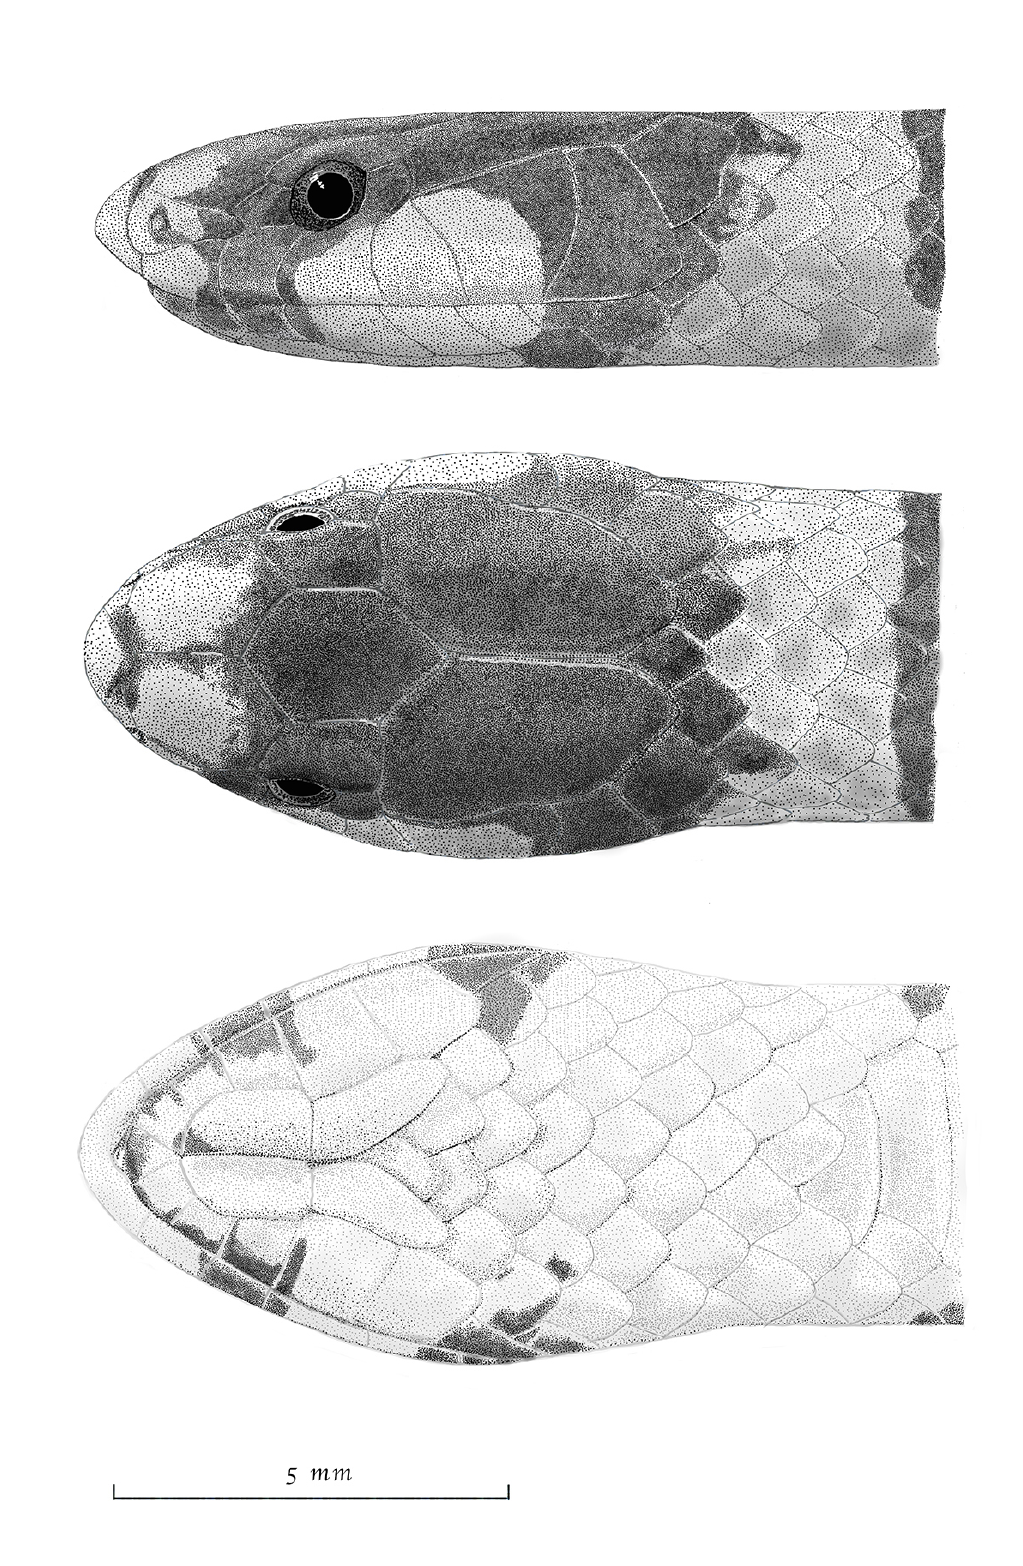
Fig. 3. Apostolepis albicollaris Lema, 2002, holotype (MCP 15219) from Minaçu, Goiás, Brazil. Head scalation. Drawings: Arthur